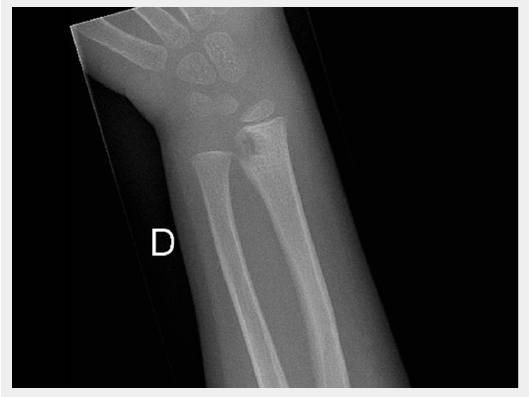
Sub-acute transphyseal osteomyelitis of the distal radius due to K. kingae in a 5-year-old boy who suffered from a